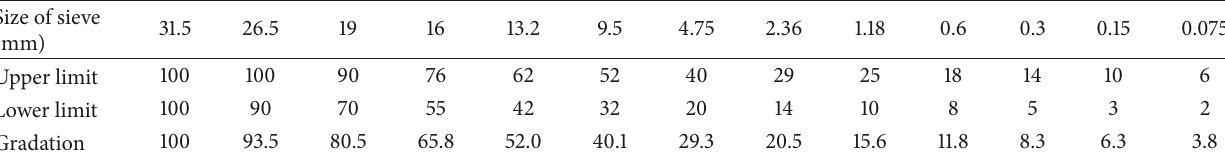
Table 13: Gradation of ATB-25.